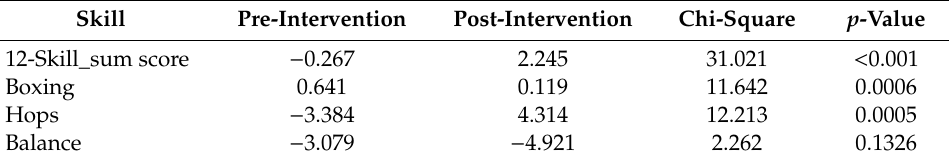
Table 6. Wald test for SCALE-UP controlling for age, All 4 Kids ©